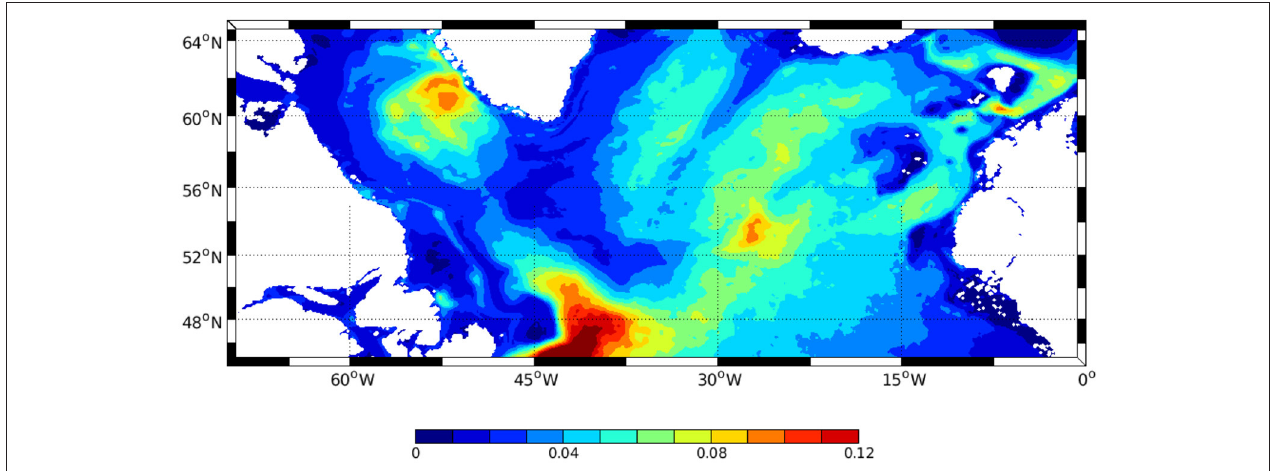
FIGURE 10 | Eddy Kinetic Energy (EKE, in m 2 /s 2 ) in the HR control simulation averaged over the period 2004–2016.